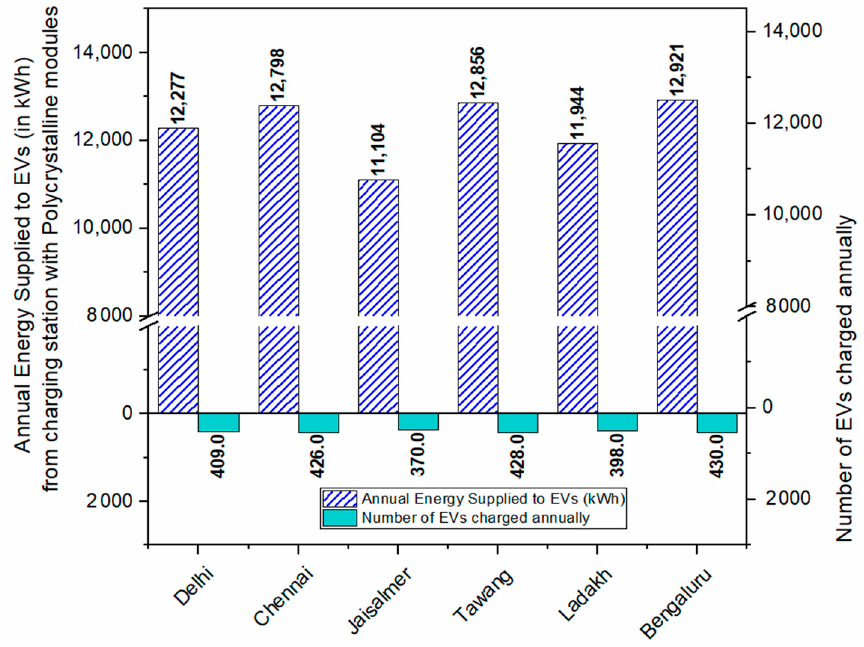
Figure 15. Annual energy supplied to EVs by the charging station using polycrystalline panels .